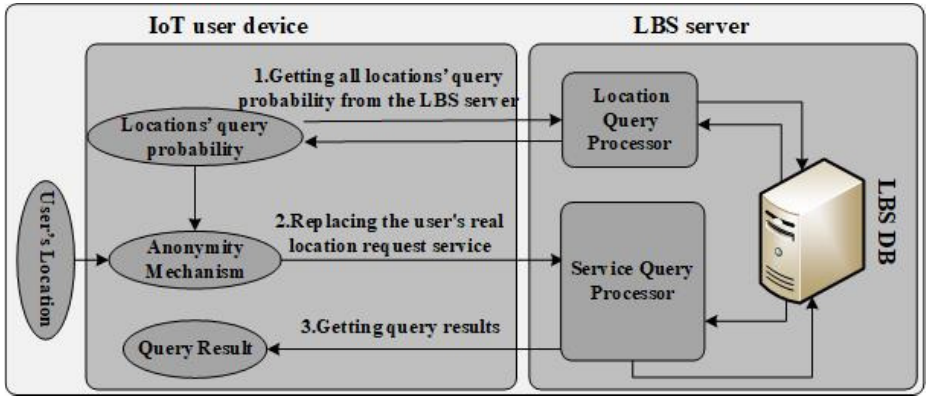
Figure 2. LSB privacy-protection model in